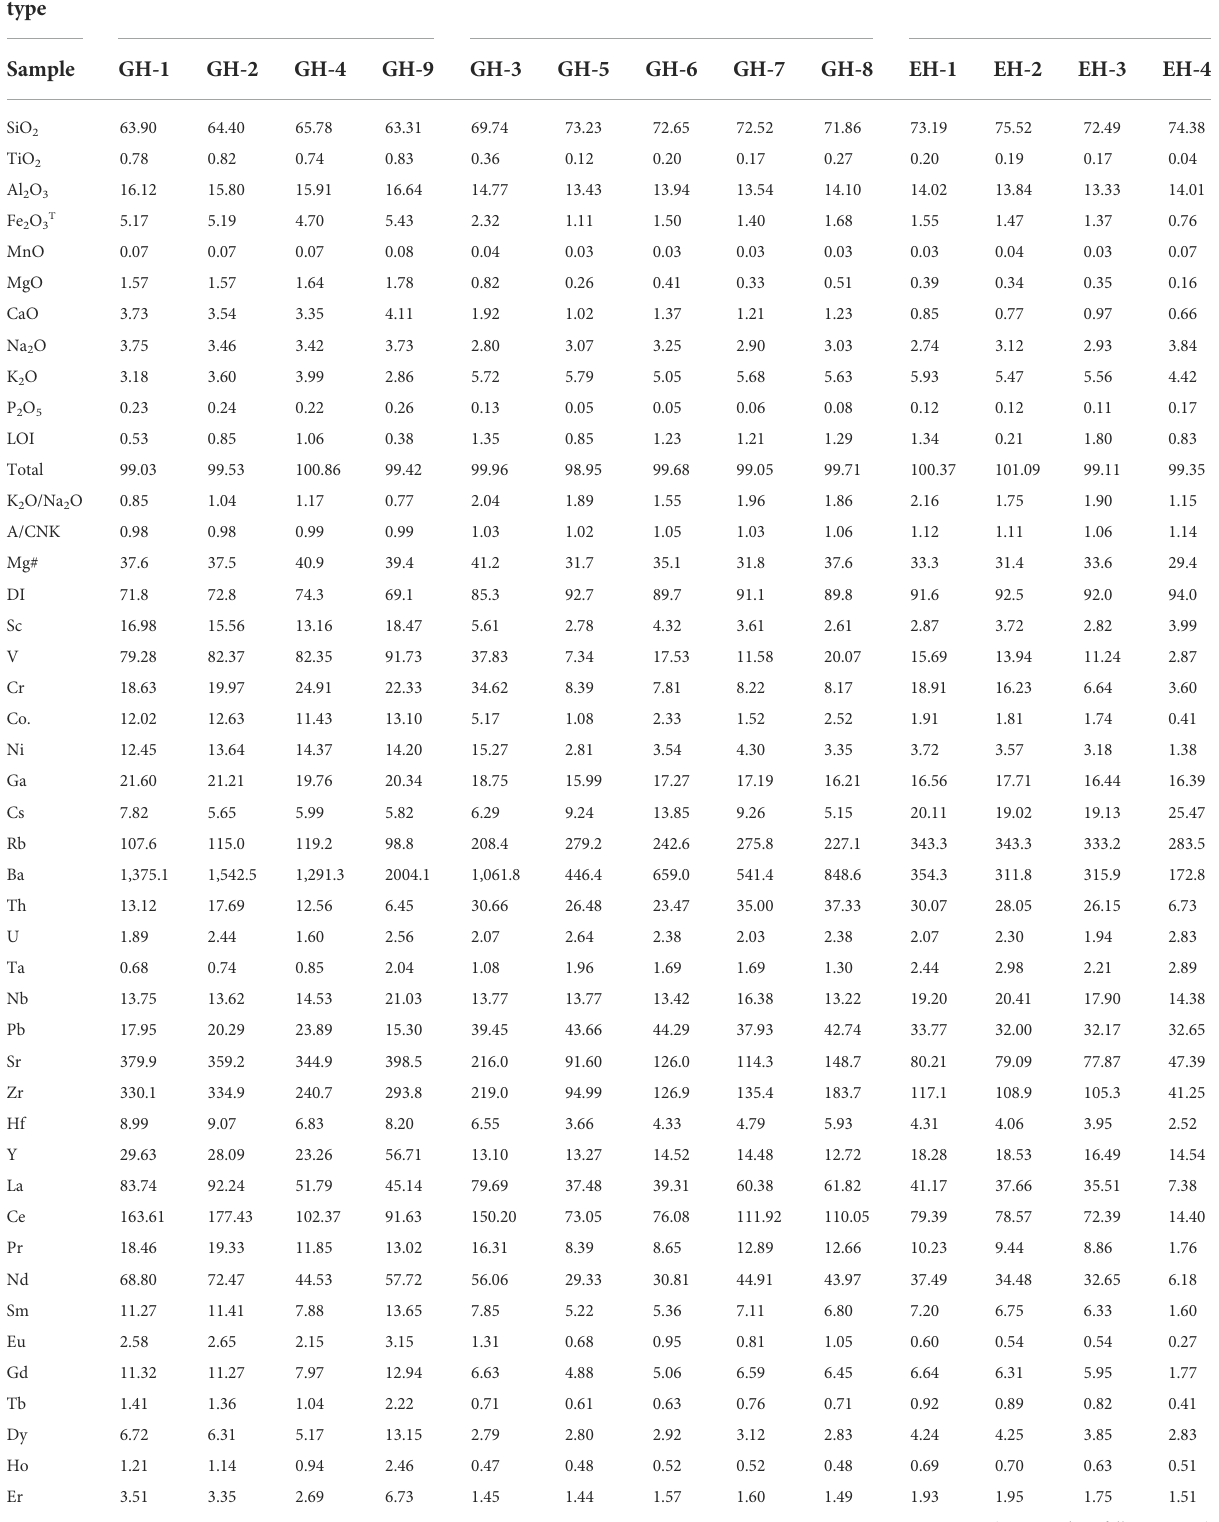
TABLE 2 Bulk rock major (wt%) and trace element (ppm) analyses of representative samples from the Gahai and Erhai plutons. Rock type